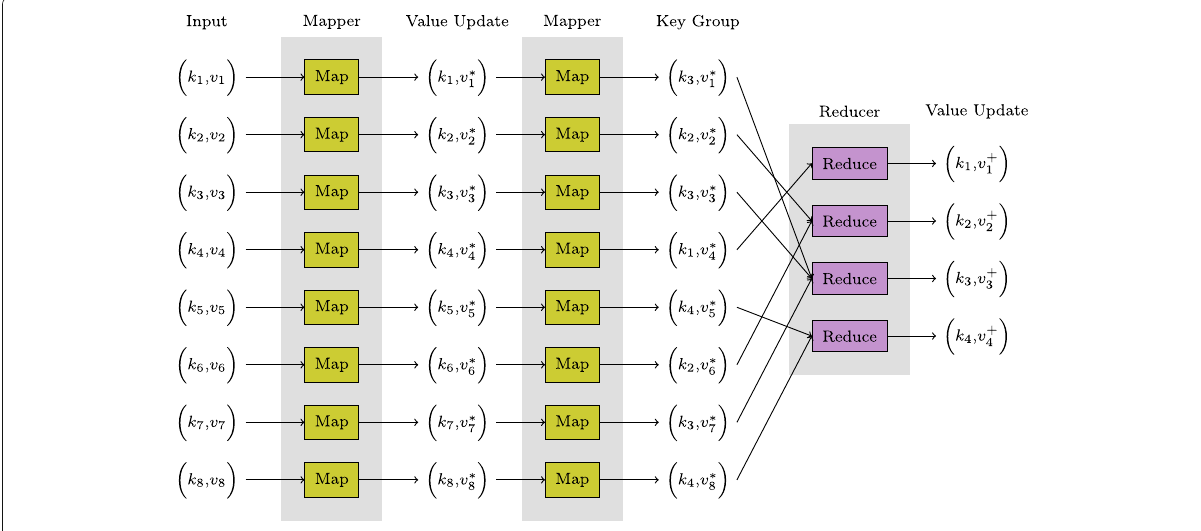
Fig. 1 General MapReduce processing